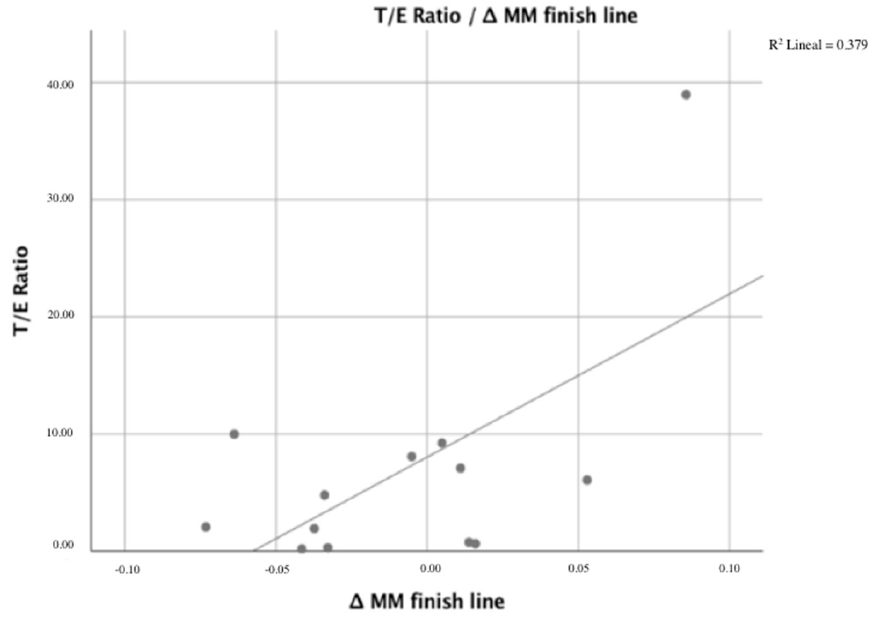
Figure 3. Correlation between ∆ MM finish line and T/E ratio.